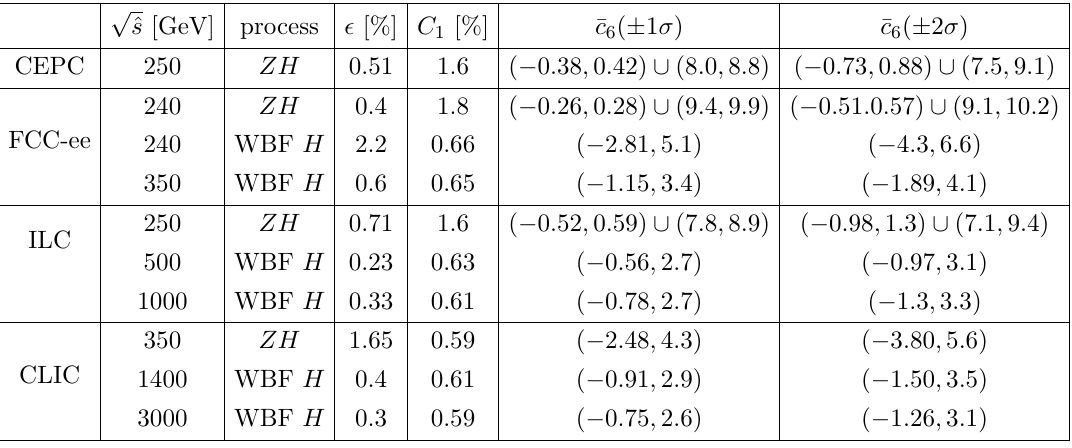
Table 4 . Expected precision (cid:15) for the measurements of single Higgs production modes and the expected 1 (cid:27) and 2 (cid:27) constraints on (cid:22) c 6 , assuming an SM measurement, are listed. The value of (cid:15)